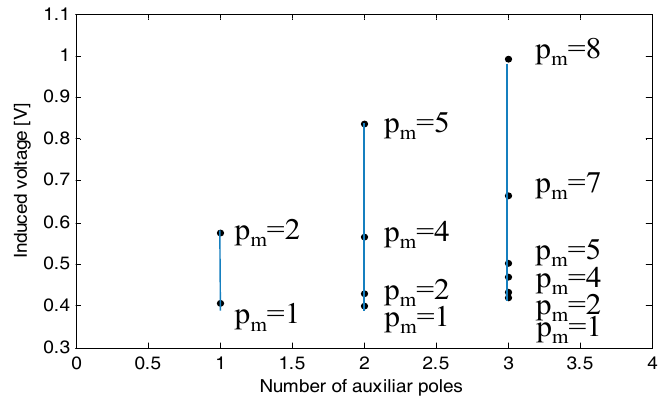
Figure 4. Induced voltages of a conductor of vernier machines.